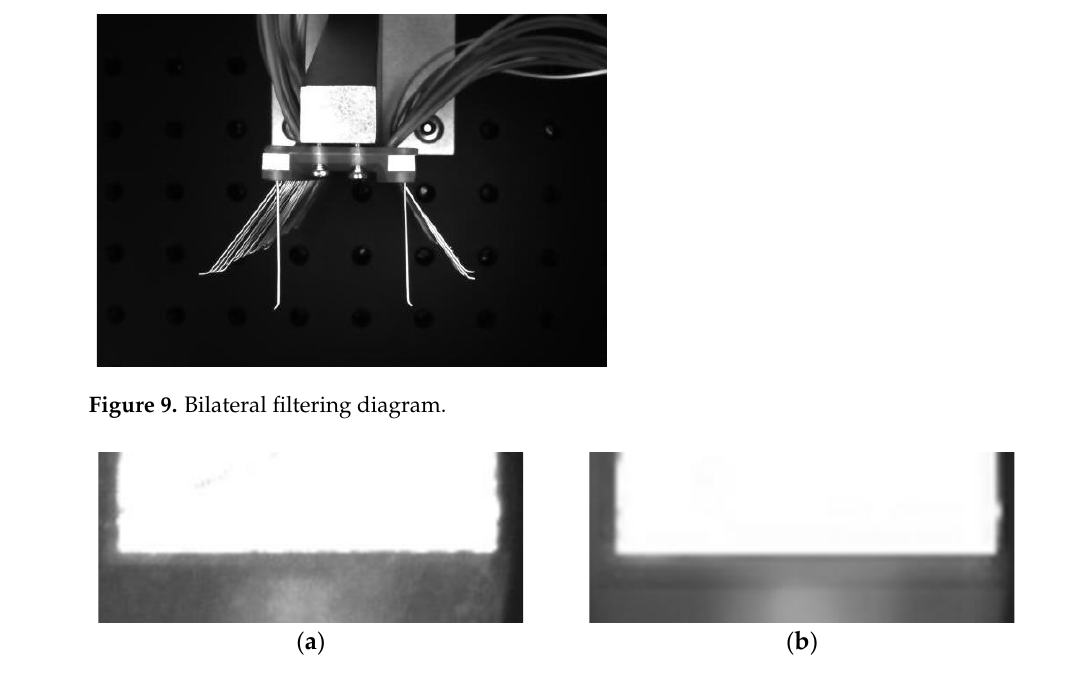
Figure 10. Bilateral filtering local comparison image: ( a ) Original partial picture of the brush wire, ( b ) Partial picture of the bilateral filter brush wire.